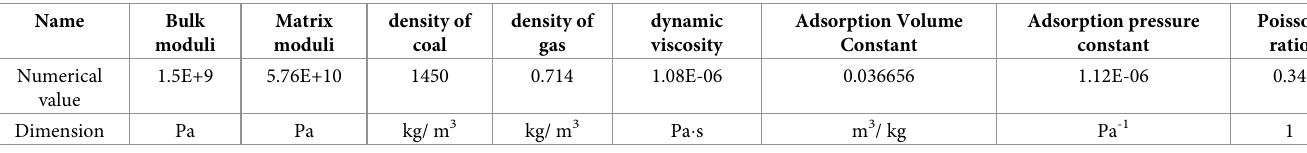
Table 3. Simplified model calculation